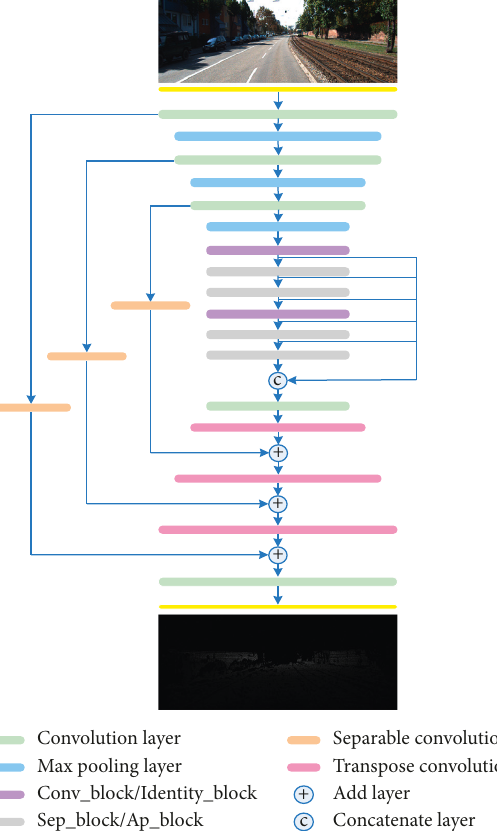
Figure 1: The neural network structure. There are only two ways to use conv_block/identity_block and sep_block/ap_block. One is to use conv_block combined with sep_block, and the other is to use identity_block combined with